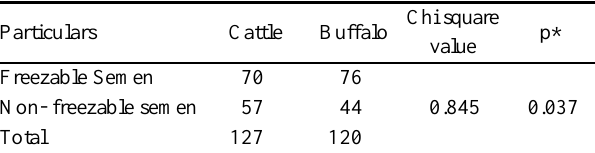
Table 2. Test of heterogeneity (chi-square test) to estimate